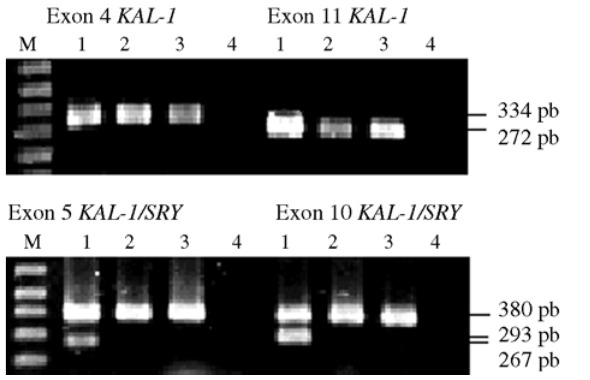
KS. Lanes 1-4 correspond, respectively, to a normal 46,XY male, patient III-4 (Family 1), patient II-6 (Family 2), and a negative control with omis- sion of the genomic DNA in the PCR. Lane M: molecular weight marker. Exons 4 and 11 ( a ) may be amplified in the three males (lanes 1-3), whereasexons5and10areamplifiedonlyinthecontrolmale(lane1).For exons 5 and 10 ( b ), a product of the SRY gene (internal positive control, 380 bp) can also be visualized.